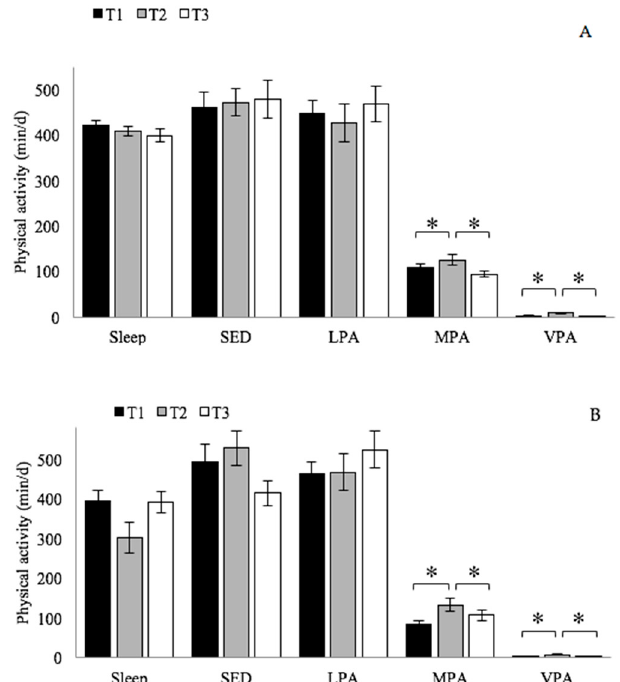
Figure 2. Mean of components of daily physical activity (Sleep, sleep time; SED, sedentary activity, intensity < 1.5 METs; LPA, light intensity physical activity, 1.5–3 METs; MPA, moderate intensity physical activity, 3–6 METs; VPA intensity physical activity > 6 METs) before the training period (T1), one week during training period (T2), and one week after two months of the end of the training (T3). Repeated measure Anova (* Significantly different, p < 0.05). ( A ) EXP group; ( B ) CTRL group. A significant increase in moderate-to-vigorous physical activity ( p = 0.0028; Power = 0.910) was recorded for both groups only during the training period and the increase was not maintained at 2 months after the end of training (EXP: 110 ± 30 min/d; 134 ± 45 and 94 ± 23 min/d; CTRL: 86 ± 30 min/d; 141 ± 42 and 110 ± 47 min/d; T1, T2, and T3, respectively). No significant time-by-group interaction was found.